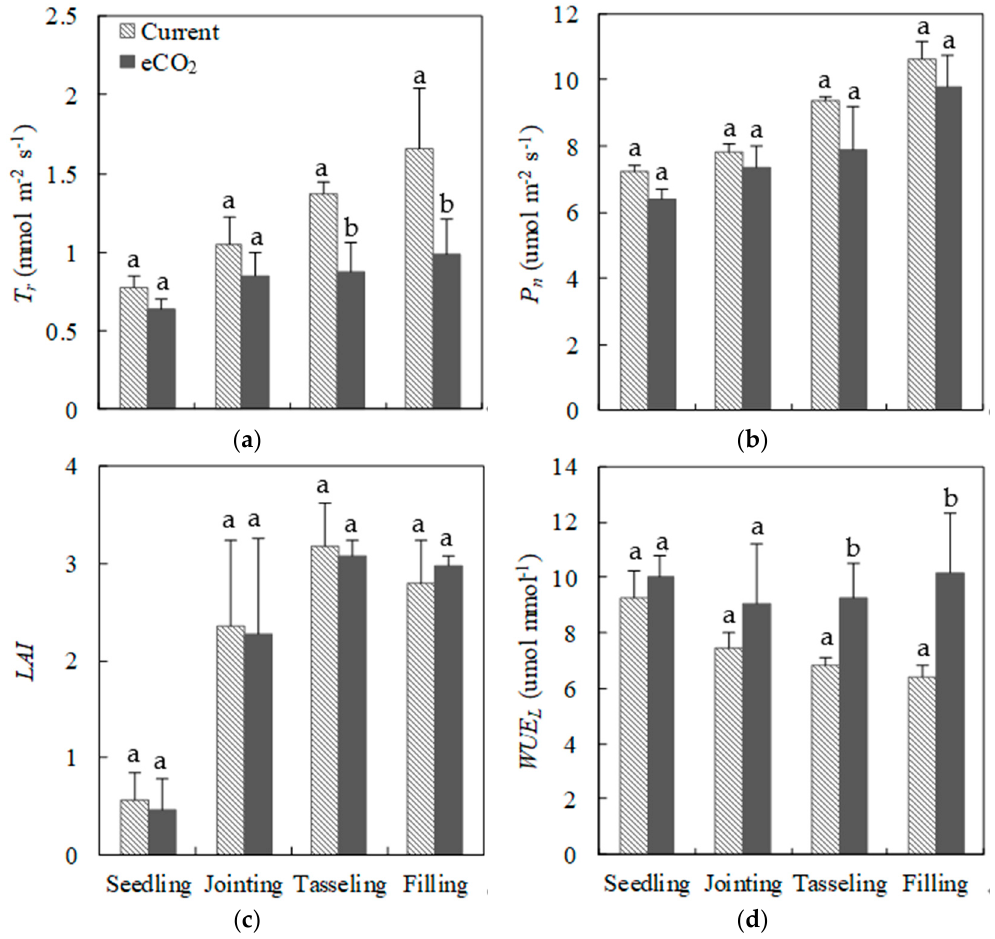
Figure 5. Seasonal variations in the ( a ) transpiration rate ( T r ), ( b ) net photosynthetic rate ( P n ), ( c ) leaf area index ( LAI ), and ( d ) leaf water use efficiency ( WUE L ) of maize at different growth stages under current and eCO 2 treatments, respectively.